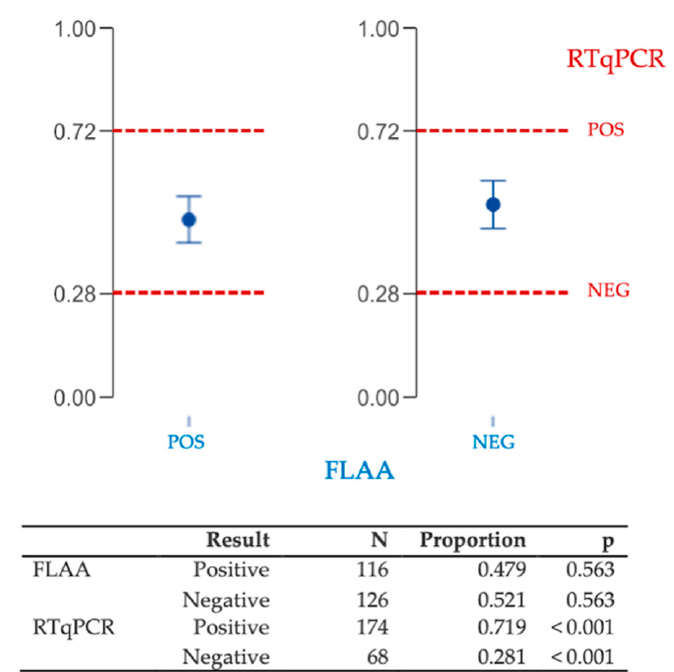
Figure 3. Binomial test for RTqPCR and FLAA positive and negative proportions. No discriminative probability was 0.5, p <0.05 were considered significant.